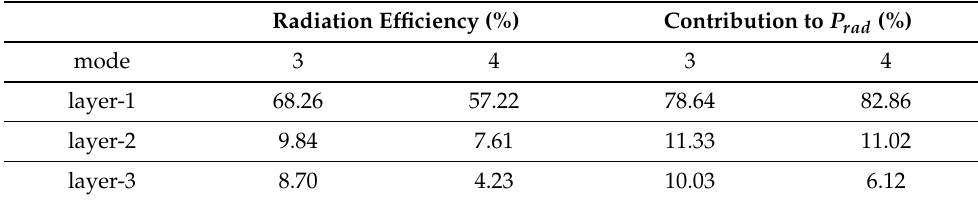
Table 3. Radiation efficiencies and contribution to the radiated power of every layer of plasmonic nanoantenna (Figure 17) for antenna modes (3,4) as appear in Table